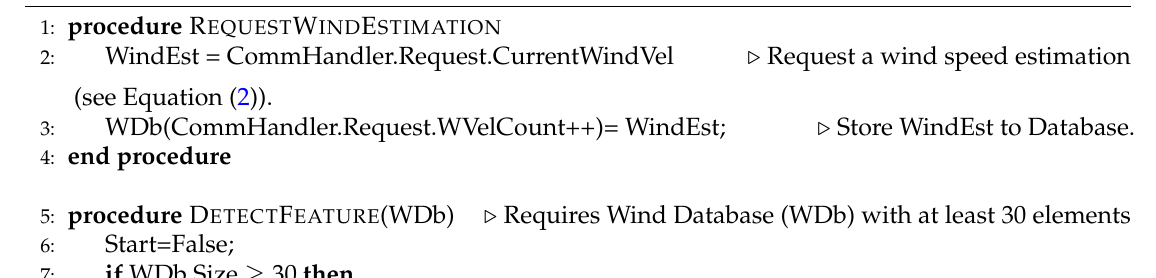
Algorithm 1 Wind prediction